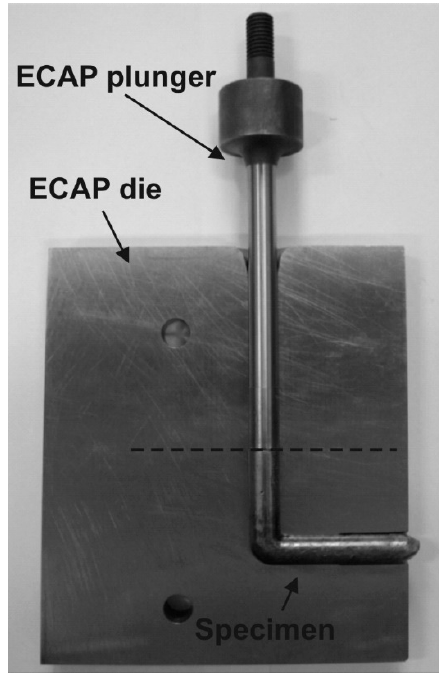
Figure 1. Schema of equal channel angular pressing (ECAP).